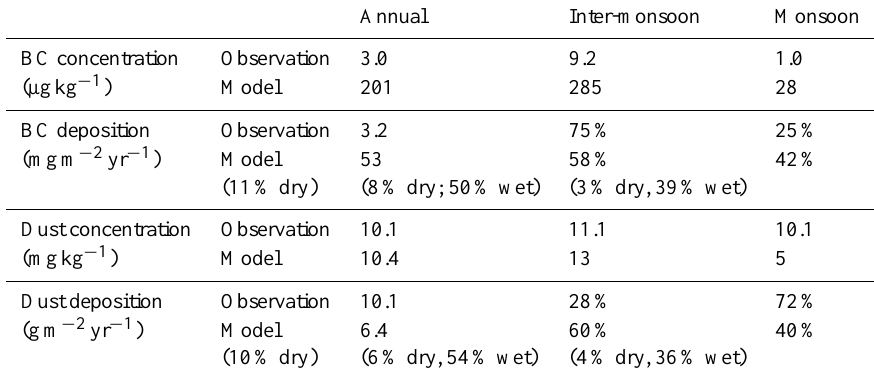
Table 2. BC and dust concentration in the snow, and BC and dust deposition reconstructed from an ice core drilled at 27.7 ◦ N, 86.9 ◦ E, 6376ma.s.l. (Ginot et al., 2013); All percentages are computed from the annual deposition values. The model grid cell is located 50km northward, where the altitude of the model surface is high enough to allow a continuous seasonal snow cover (28.0 ◦ N, 86.9 ◦ E, 5552ma.s.l.). Ginot et al. (2013) computed the annual mean aerosol concentration by multiplying the seasonal snow accumulation by the seasonal aerosol concentration. For the entire period 1998–2008, they used the winter concentration of the last year, since it was the only one available, the others being eroded by winds. Inter-monsoon modelled concentrations include winter values. Annual modelled values are the temporal average of the aerosol concentration in the top snow layer of the model (i.e. a constant surface depth of 8mm snow water). Annual Inter-monsoon Monsoon BC